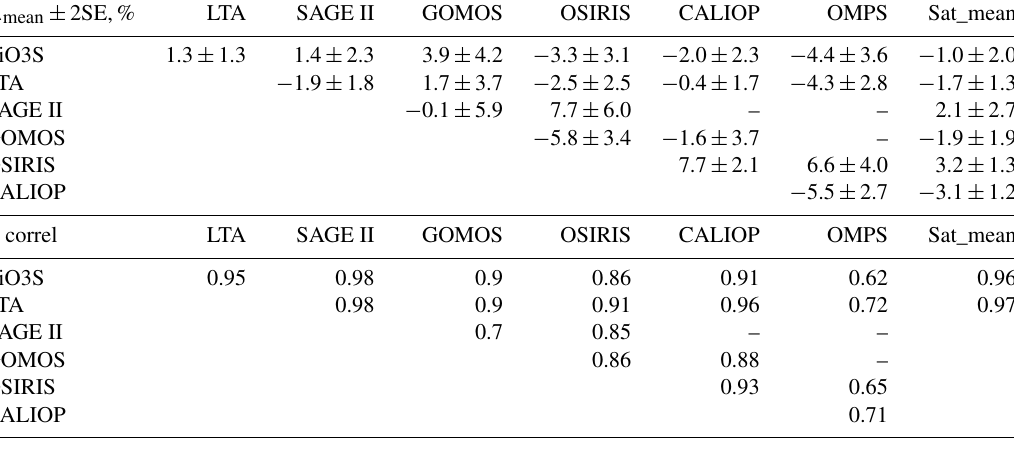
Table 2. Intercomparison of stratospheric aerosol optical depth between 17 and 30km (sAOD 1730 ) series displayed in Fig. 1. Mean relative difference (cid:49) mean ± 2 standard errors (top) and correlation coefficient R (bottom). The relative difference in the top panel is calculated as 100% (X row − X column )/(X row + X column ) , where X is the sAOD 1730 value averaged over the entire observation time span of the respective instrument (see Table 1) or the mean of all satellite instruments (last column).